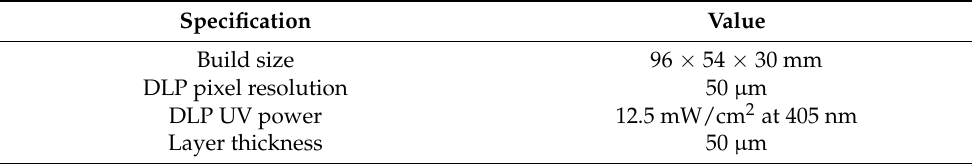
Table 1. Speci fi cation of fabricated DLP 3D printer. Table 1. Specification of fabricated DLP 3D printer.